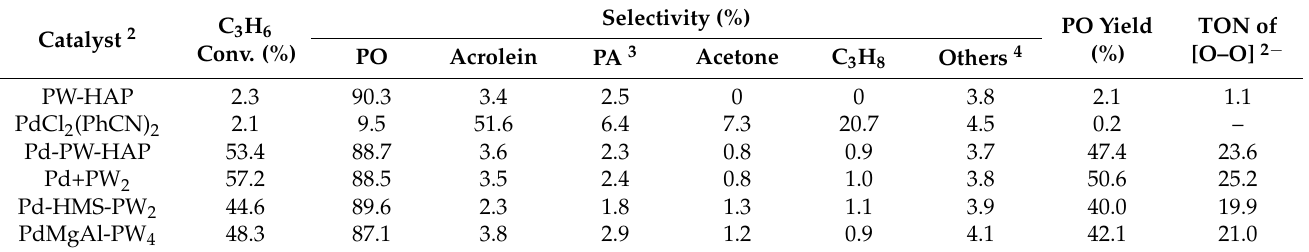
Table 2. Results of propylene epoxidation by O 2 in methanol over various catalysts 1 . C 3 H 6 Catalyst 2 Conv.